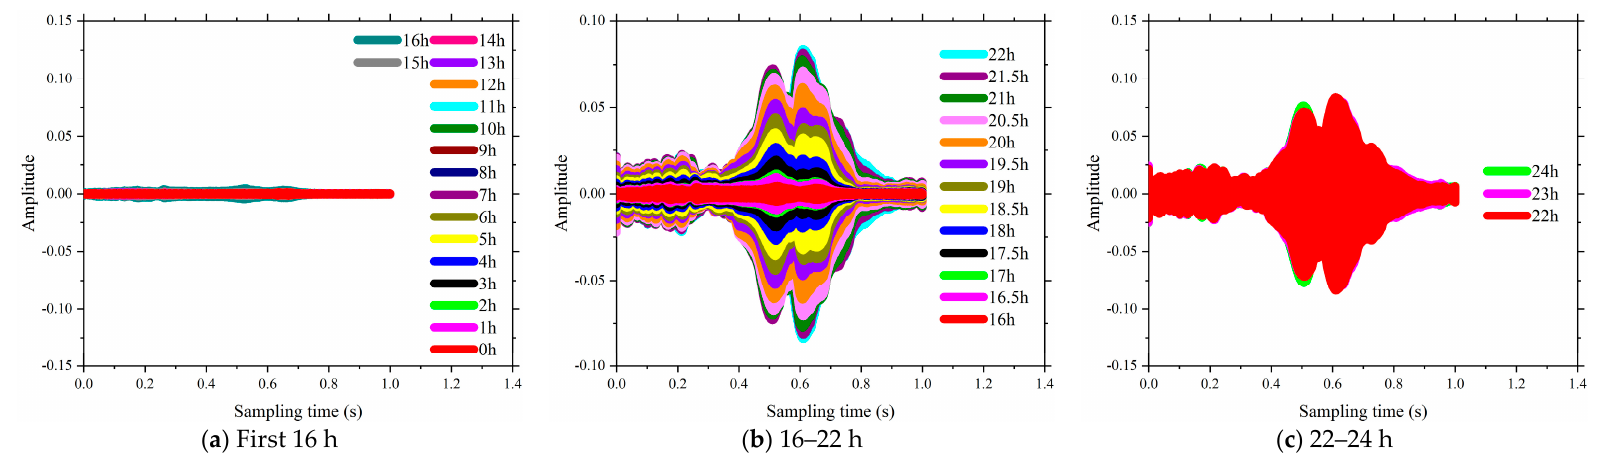
Figure 15. Influence of volume of fly ash on the signal amplitude at hydration monitoring (FA-40%).